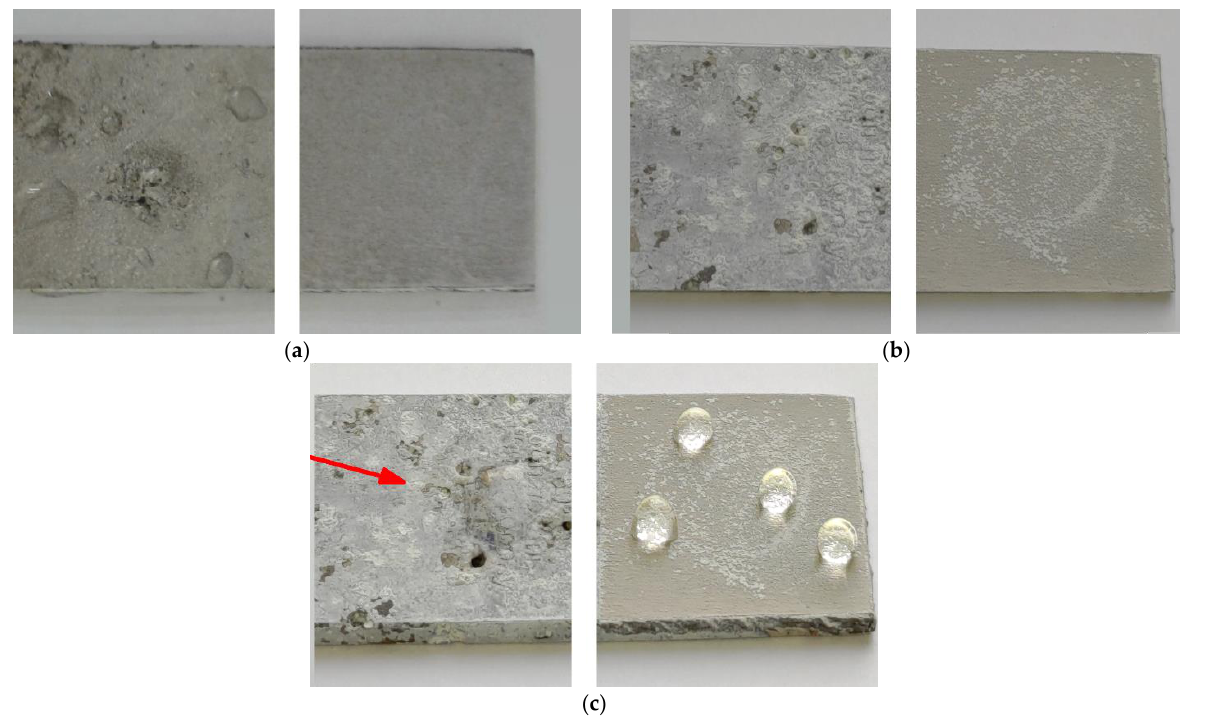
Figure 5. Corrosion of hydrophobic (left) and superhydrophobic (right) samples upon salt fog exposure: ( a ) after 25 h, ( b ) after 250 h, ( c ) after 250 h with subsequent mild washing and drying.